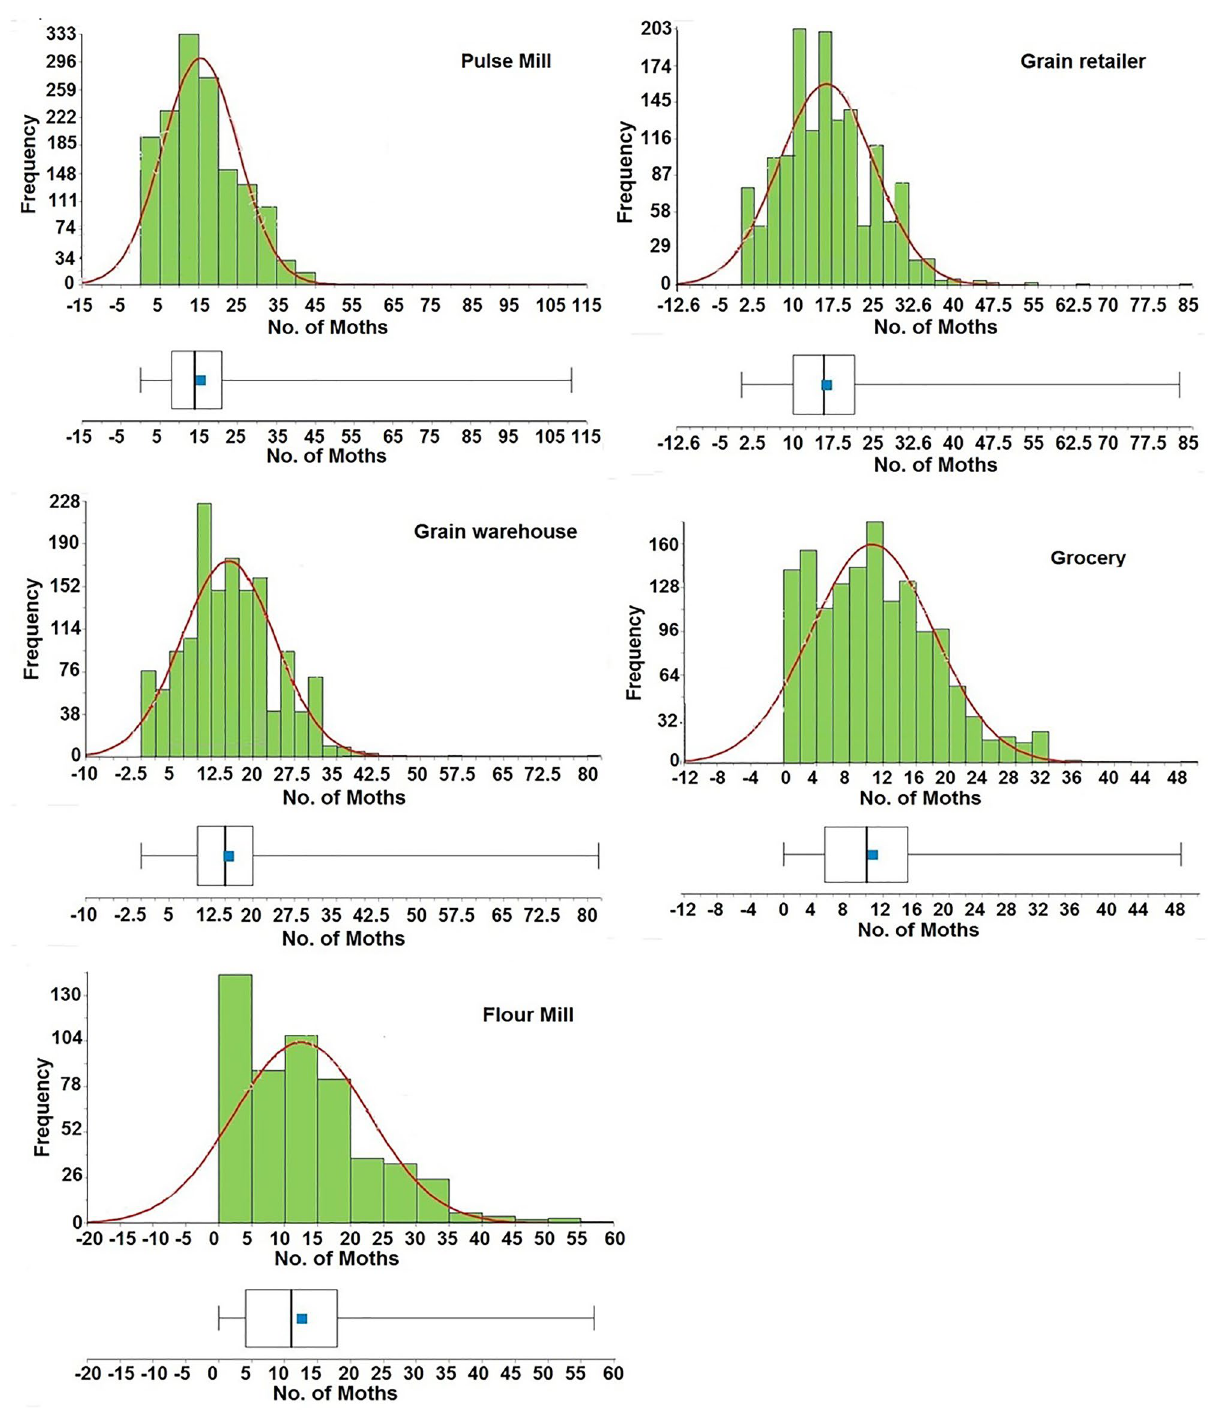
Figure 3. Histograms of the raw data for the weekly counts for Plodiainterpunctella adult captures in pheromone-baited traps at different food facilities located in Rajshahi municipality